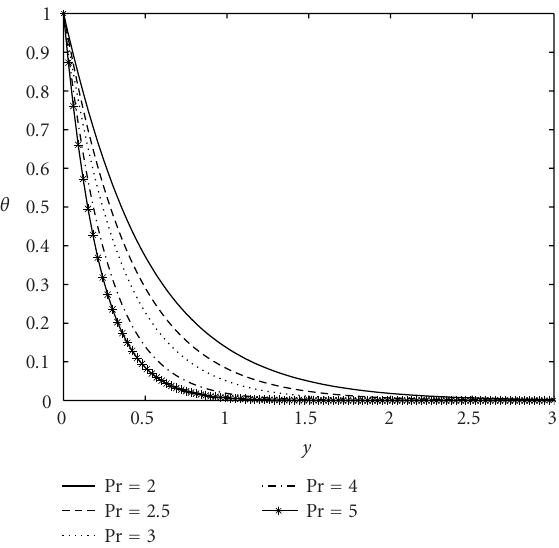
Figure 4.9. Temperature profile for Gr = 5 . 0, S = 1 . 0, ω = 10 . 0, z = 0 . 2, t = 0 . 2, (cid:2) = 0 . 2.